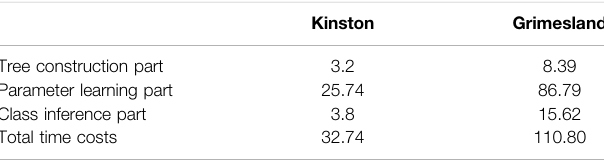
TABLE 5 | Time costs of different components of our model on two datasets (seconds)